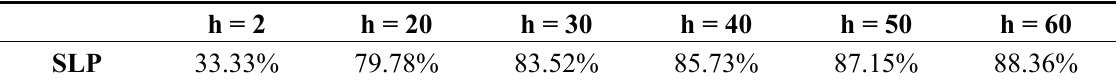
Table 3. The percentage of random directed paths